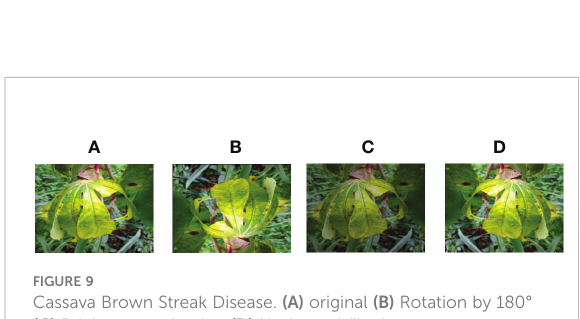
FIGURE 9 Cassava Brown Streak Disease. (A) original (B) Rotation by 180° (C) Brightness reduction (D) Horizontal fl ipping.